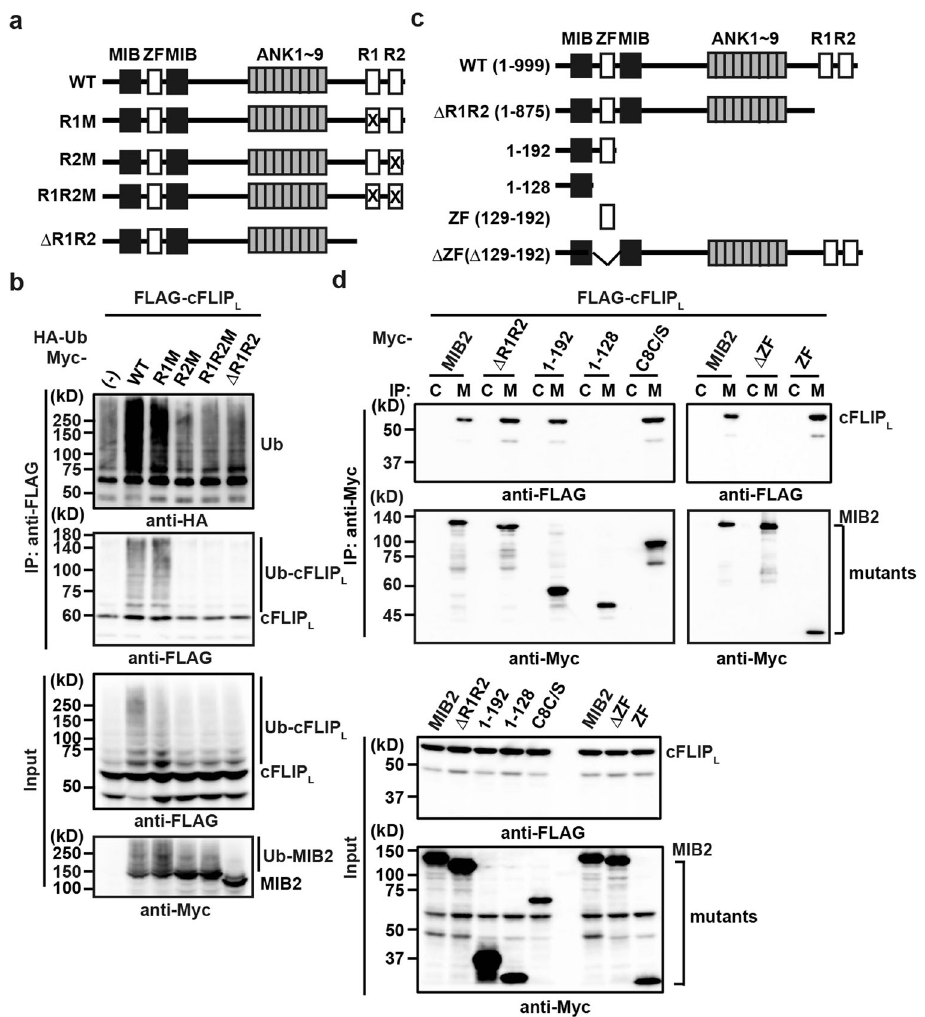
Fig. 3 MIB2 ubiquitylates cFLIP L in a RING domain-dependent manner. a Domain structures of MIB2 and their mutants. ZF, zinc fi nger; ANK, ankyrin repeats; R, RING fi nger domain. X indicates the RING fi nger mutants in which active cysteines at 900 and 977 are replaced by serines, including R1M (C900S), R2M (C977S), and R1MR2M (CC900/977SS). b HEK293 cells were transfected and analysed as Fig. 1c. c Deletion mutants of MIB2. Numbers indicate the amino acids included in the respective mutant. d HEK293 cells were transfected and analysed as in Fig. 1e. C8C/S indicates a protease-inactive mutant of caspase 8. Results are representative of two independent experiments ( b , d